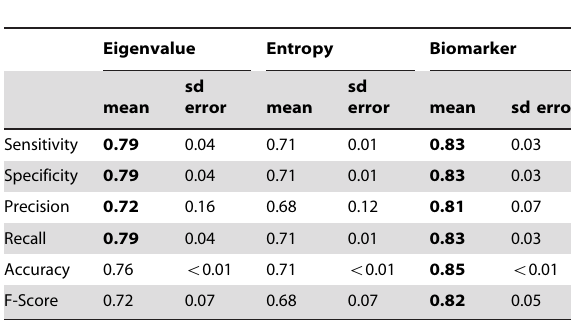
Table 2. Error measures (mean values and standard errors) for the evaluation of the classification. Best results are highlighted in bold.